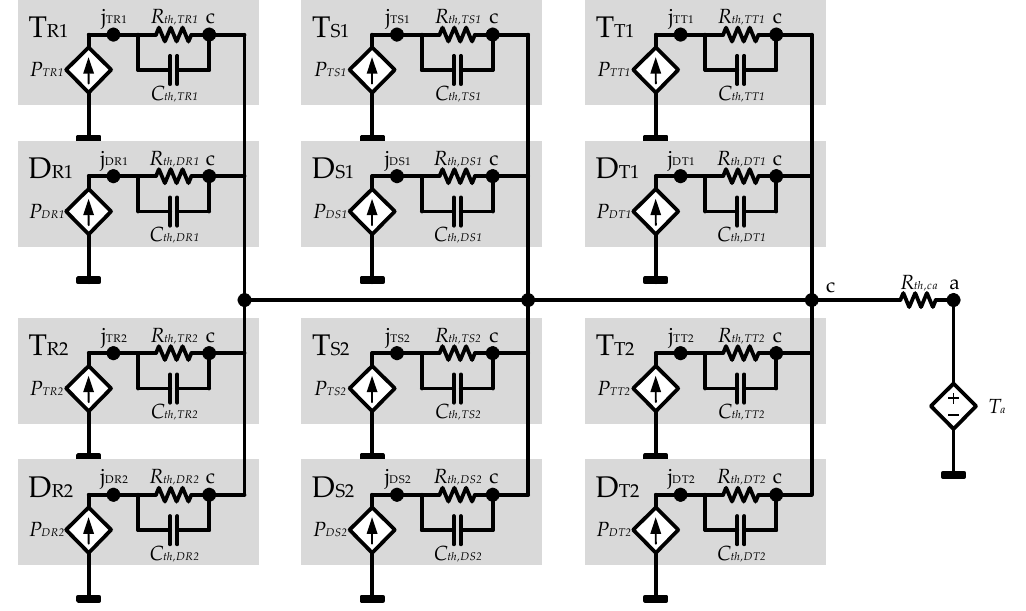
Figure 19. 12x1 simplified RC network model. Each semiconductor is marked by a grey area. Figure 19. 12 × 1 simplified RC network model. Each semiconductor is marked by a grey